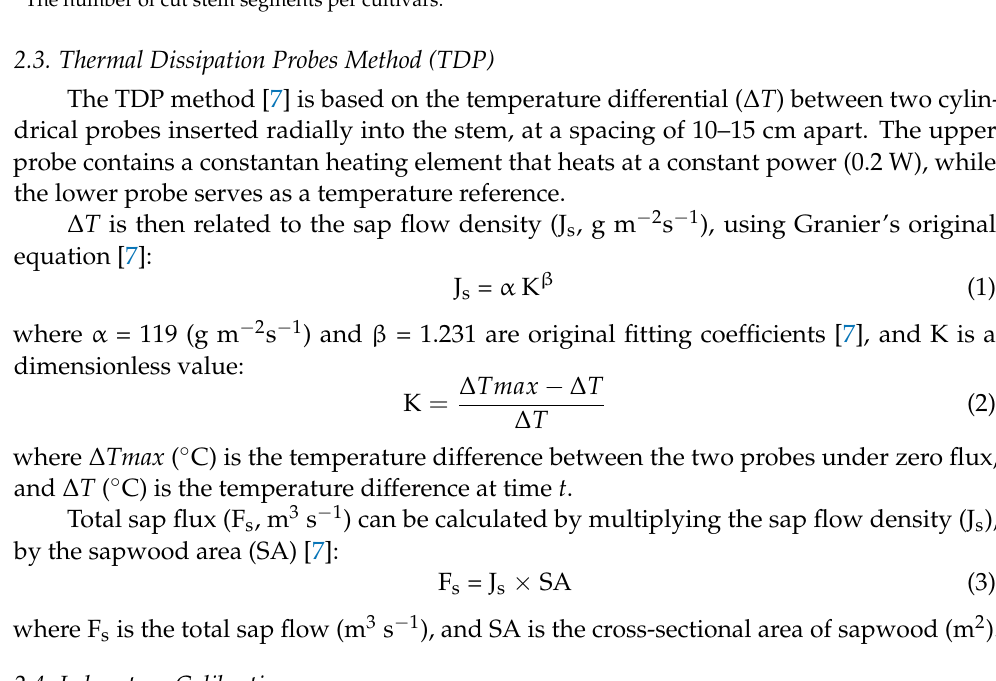
Table 1. Properties of stem segments used in the calibration experiment. Circumference and diameter are given as mean ± standard deviation. Cultivars Circumference (cm) Diameter (cm) N * ‘Assiane’ 86.96 ± 0.95 27.69 ± 0.30 3 ‘Tadmament’ 85.16 ± 0.76 27.12 ± 0.24 3 ‘Khalt’ 94.83 ± 3.40 30.20 ± 1.08